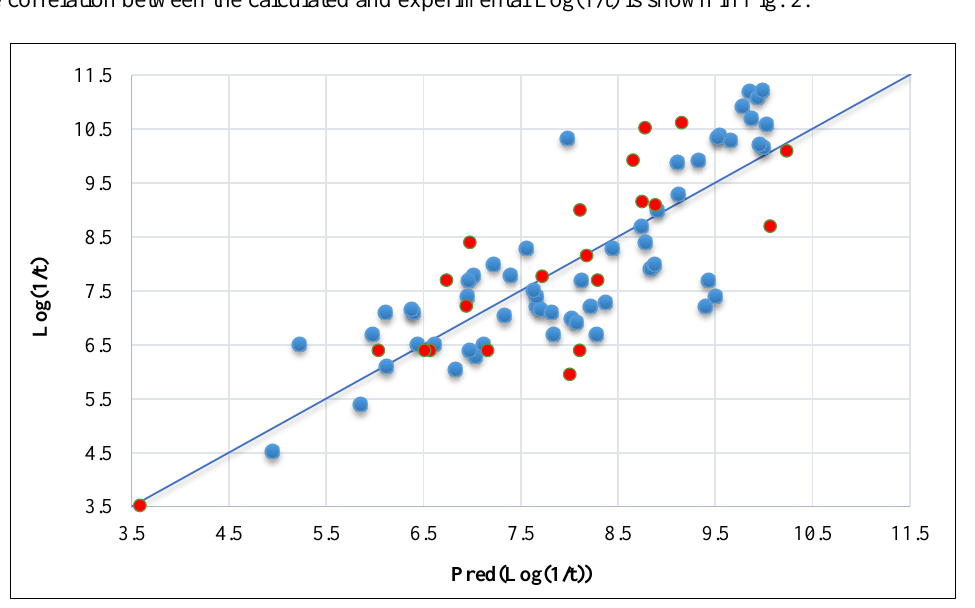
Figure 1. Correlations of observed and predicted Log(1/t) with MLR stepwise (training set in blue; test set in